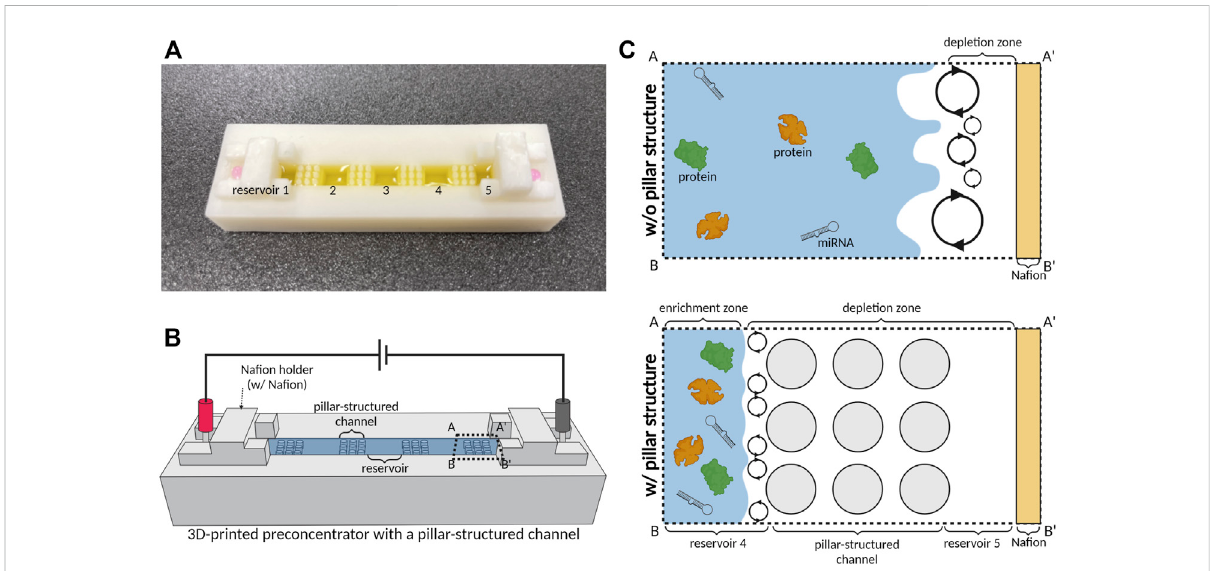
FIGURE 1 Schematic illustration of a 3D-printed preconcentrator with a pillar-structured channel (3DP 2 ). (A) Optical image of a 3D-printed device with fi ve reservoirs connected with a pillar-structured channel. (B) Scheme showing the preconcentration of 3DP 2 . (C) Schematic diagrams of preconcentrationwithpillarstructure.Weappliedtheelectrical fi eldof100 Vacrossmillimeter-scalechannelsandreservoirsandacquiredthestable preconcentration only with a pillar-structured channel between